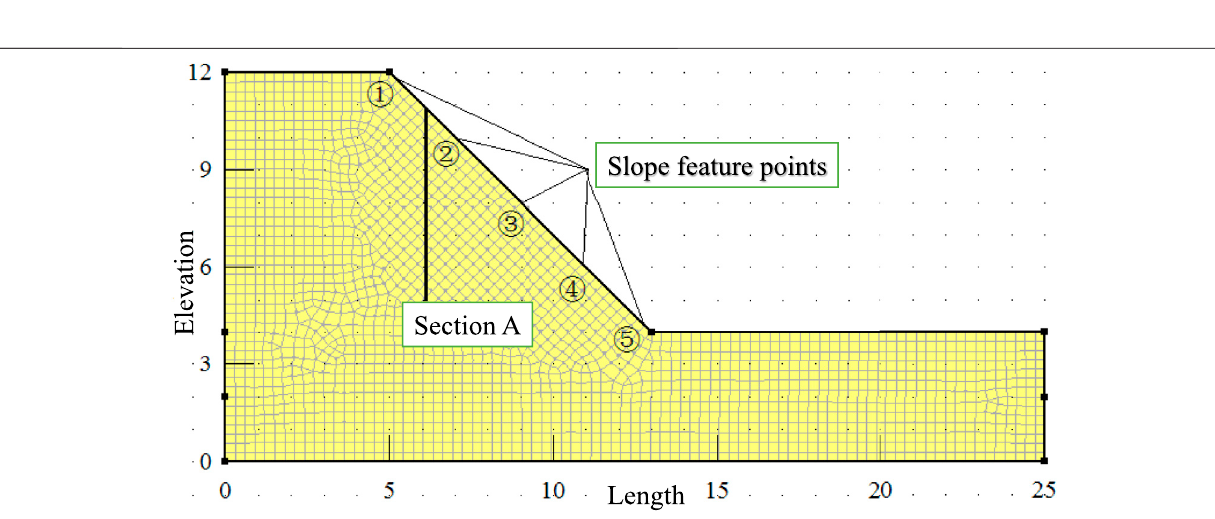
FIGURE 9 | Two-dimensional geometry and element mesh of the silt subgrade